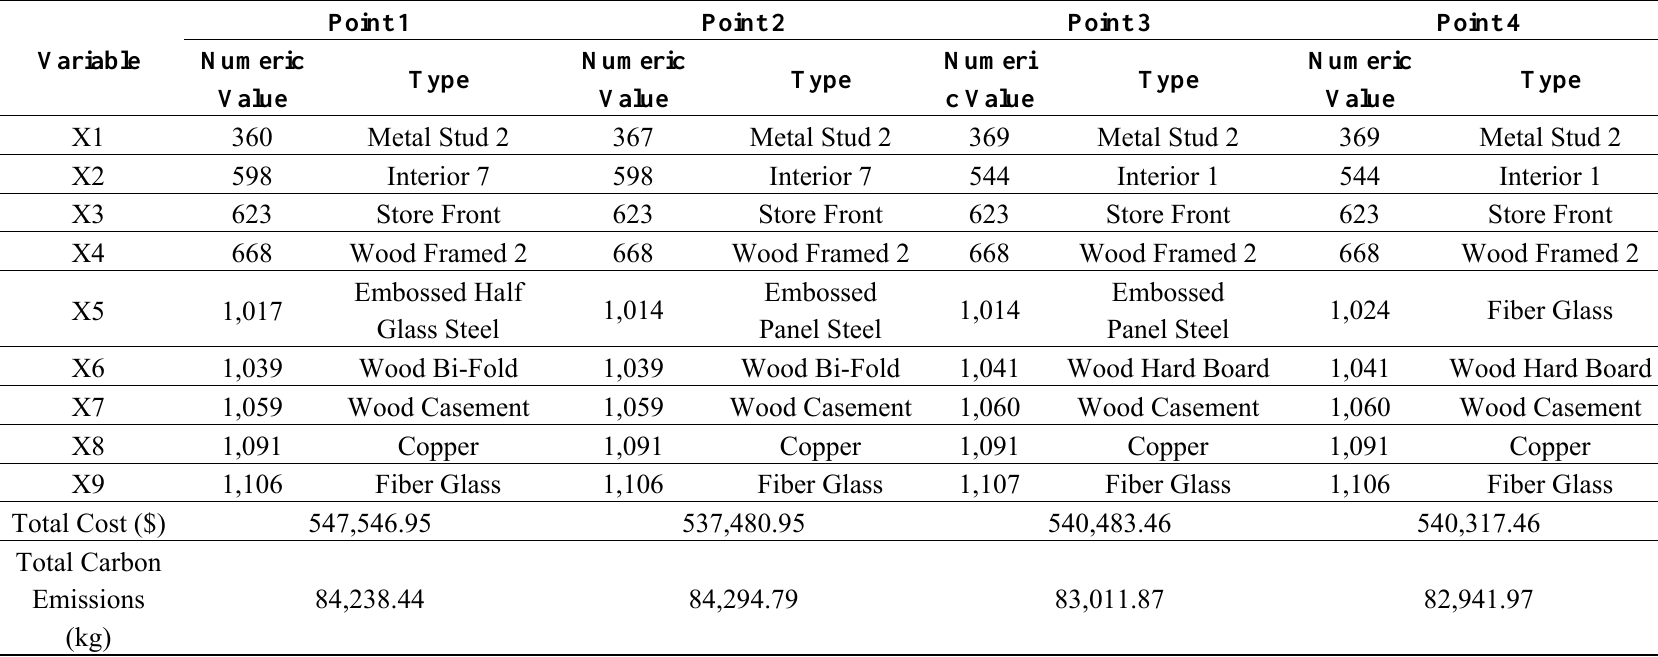
Table 11. Optimal Solutions based on Scenario